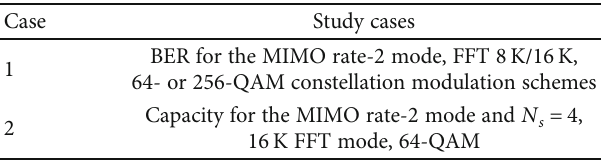
Figure 3: The DVB-NGH MIMO rate-2 receiver diagram. Table 2: Study cases.